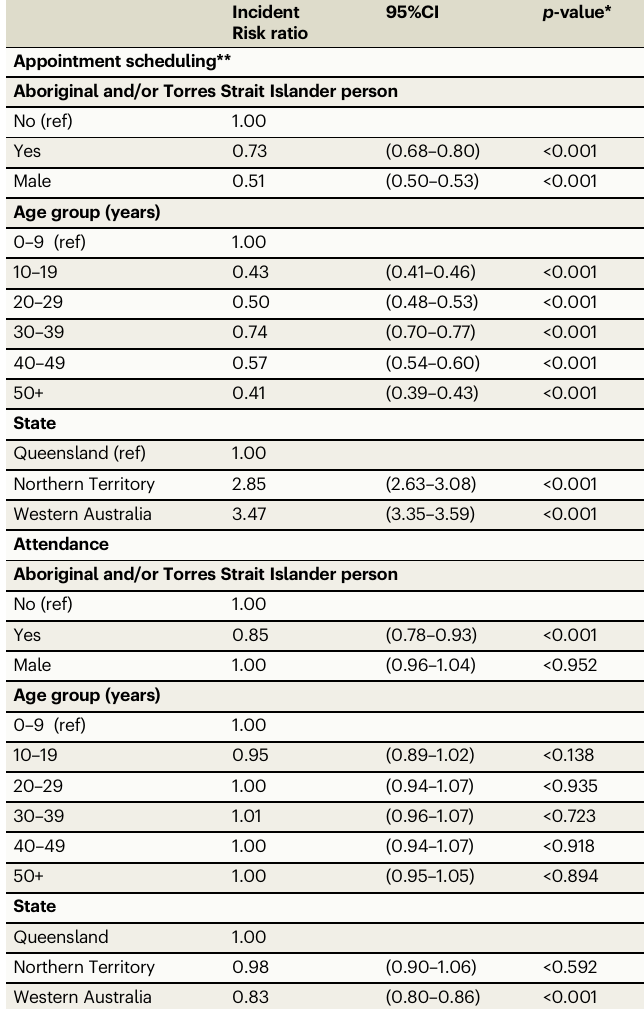
Table 5 | Disparity in appointment scheduling, multivariate analysis using Poisson regression Incident Risk ratio